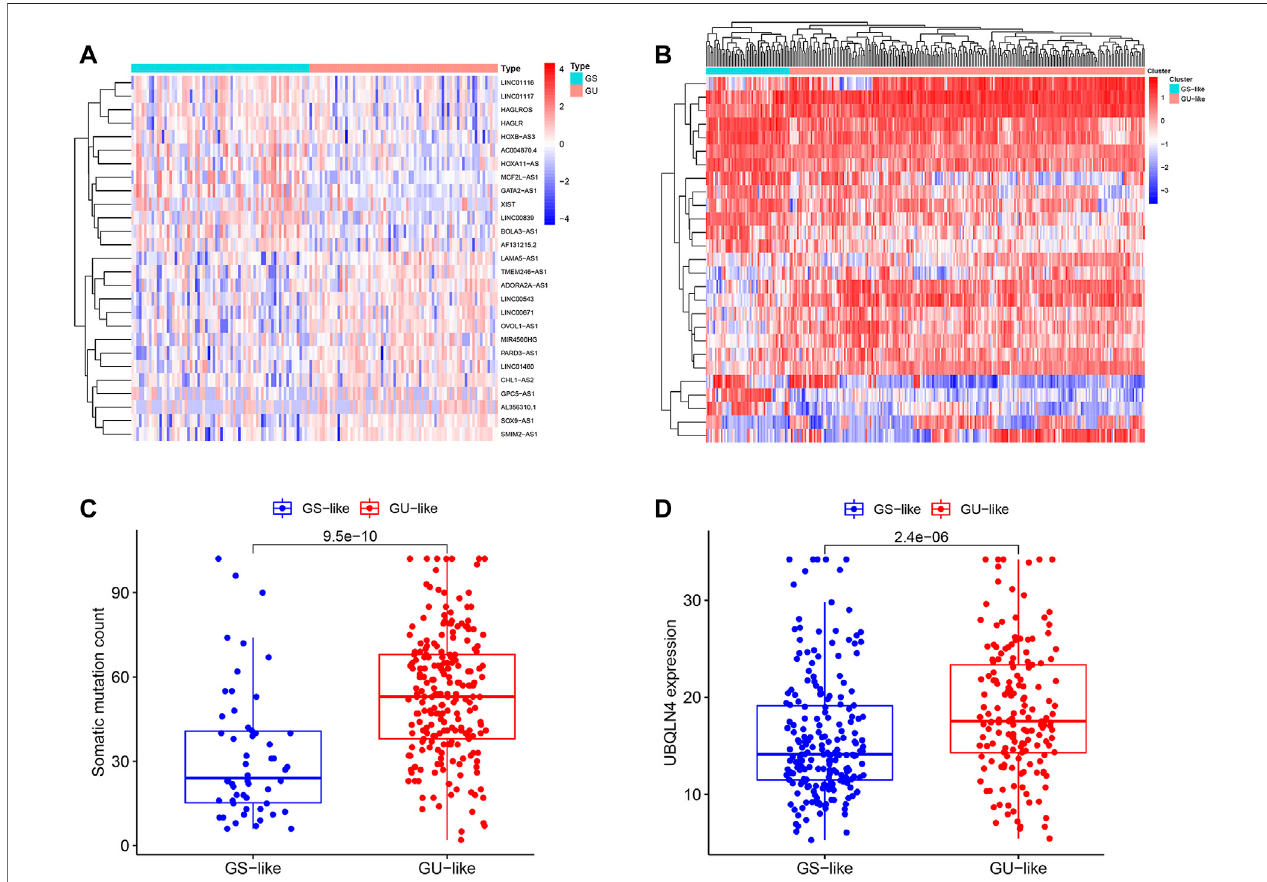
FIGURE 1 | Identi fi cation of genomic instability-associated lncRNAs in patients with KIRP. (A) . Unsupervised clustering of 321 patients with KIRP was performed according to the quanti fi cation of the expression of 27 lncRNAs. The blue cluster on the left indicates the GS like cluster, while the red cluster on the right indicates the GU like cluster. (B) .Heatmapsof27genomicinstability-relatedlncRNAsintheGS like andGU like clusters. (C) .BoxplotsofsomaticmutationcountsintheGS like andGU like clusters. (D) . Comparison of UBQLN4 expression level between the GS like and GU like